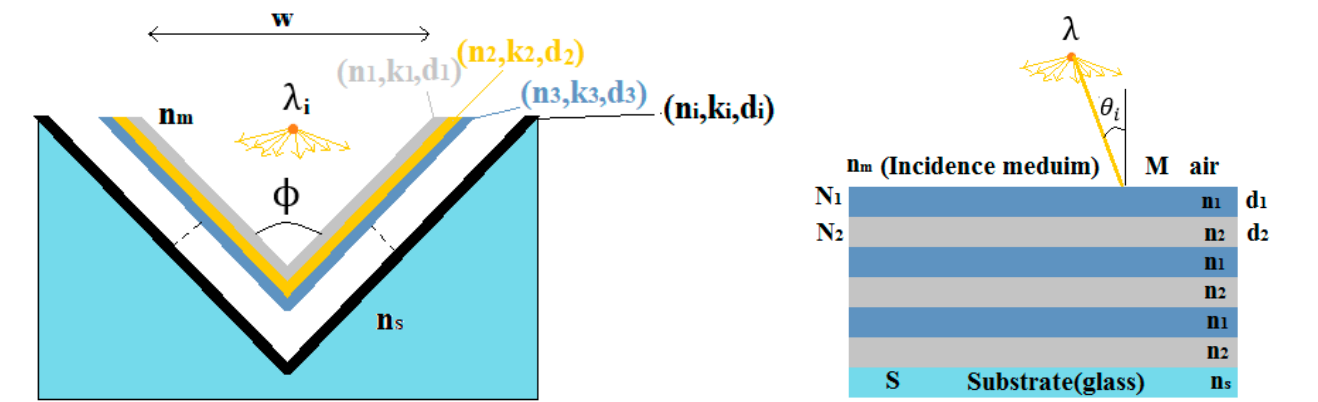
Figure 5. Representation of a V-shaped cavity whose sides are made of thin layer materials (the figure on the right corresponds to a stack of 6 layers).